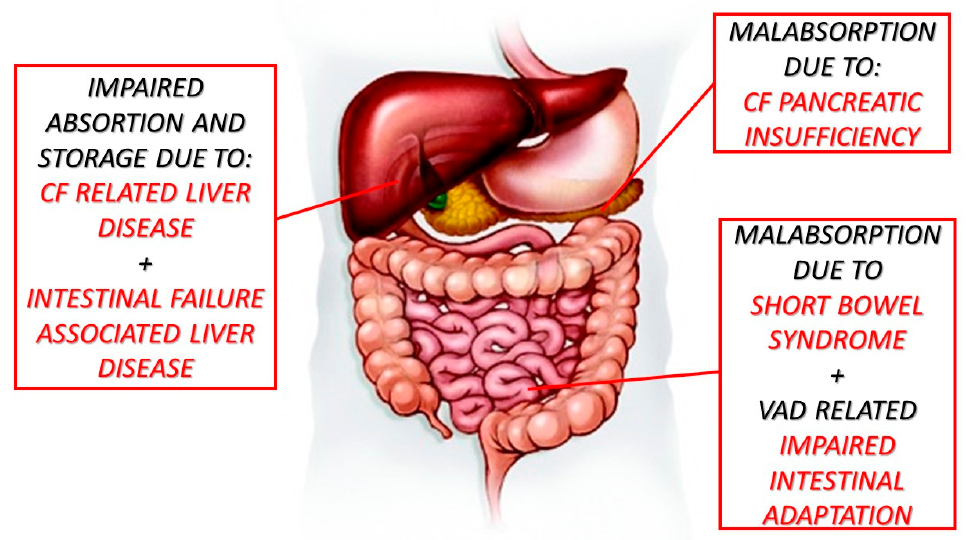
Figure 3. Risk factors related to vitamin A deficiency. CF = cystic fibrosis; VAD = vitamin A